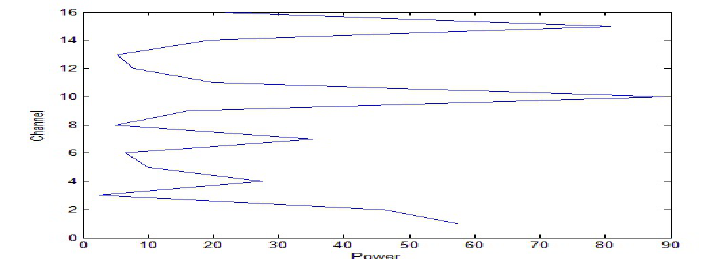
Figure 11. The energy distribution curve of the time-reversed signal at 7 kHz along the depth direction.